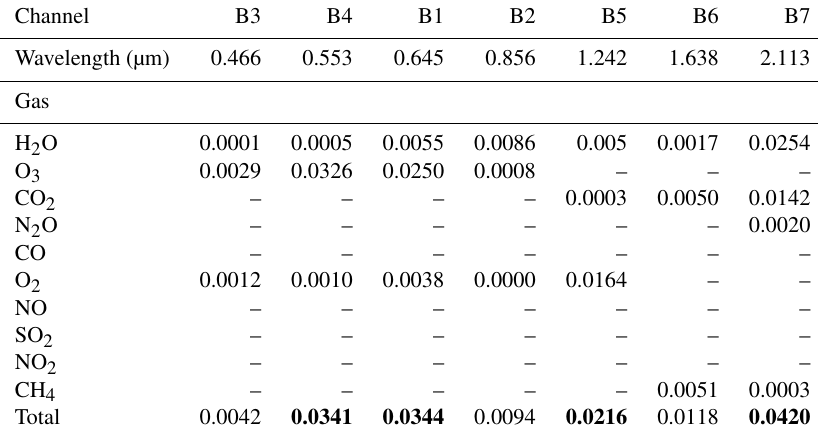
Table 2. Optical depth of major atmospheric gases in seven MODIS channels.